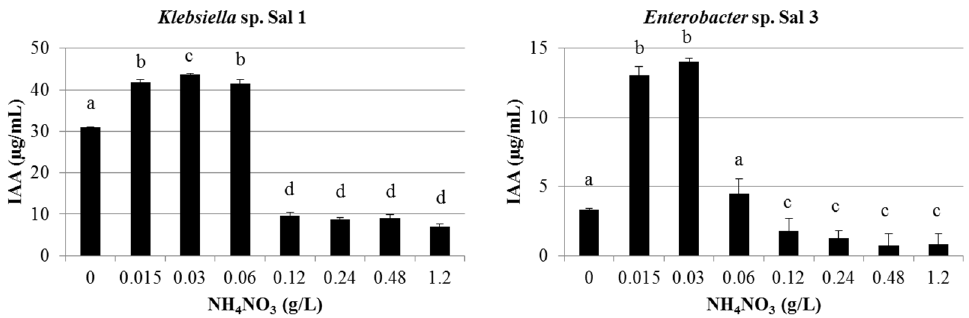
Figure 2. IAA production at different levels of nitrogen in ½ MS liquid medium. The bars represent standard deviation ( n = 3) and different letters indicate significant differences at P < 0.01 by Tukey’s test.